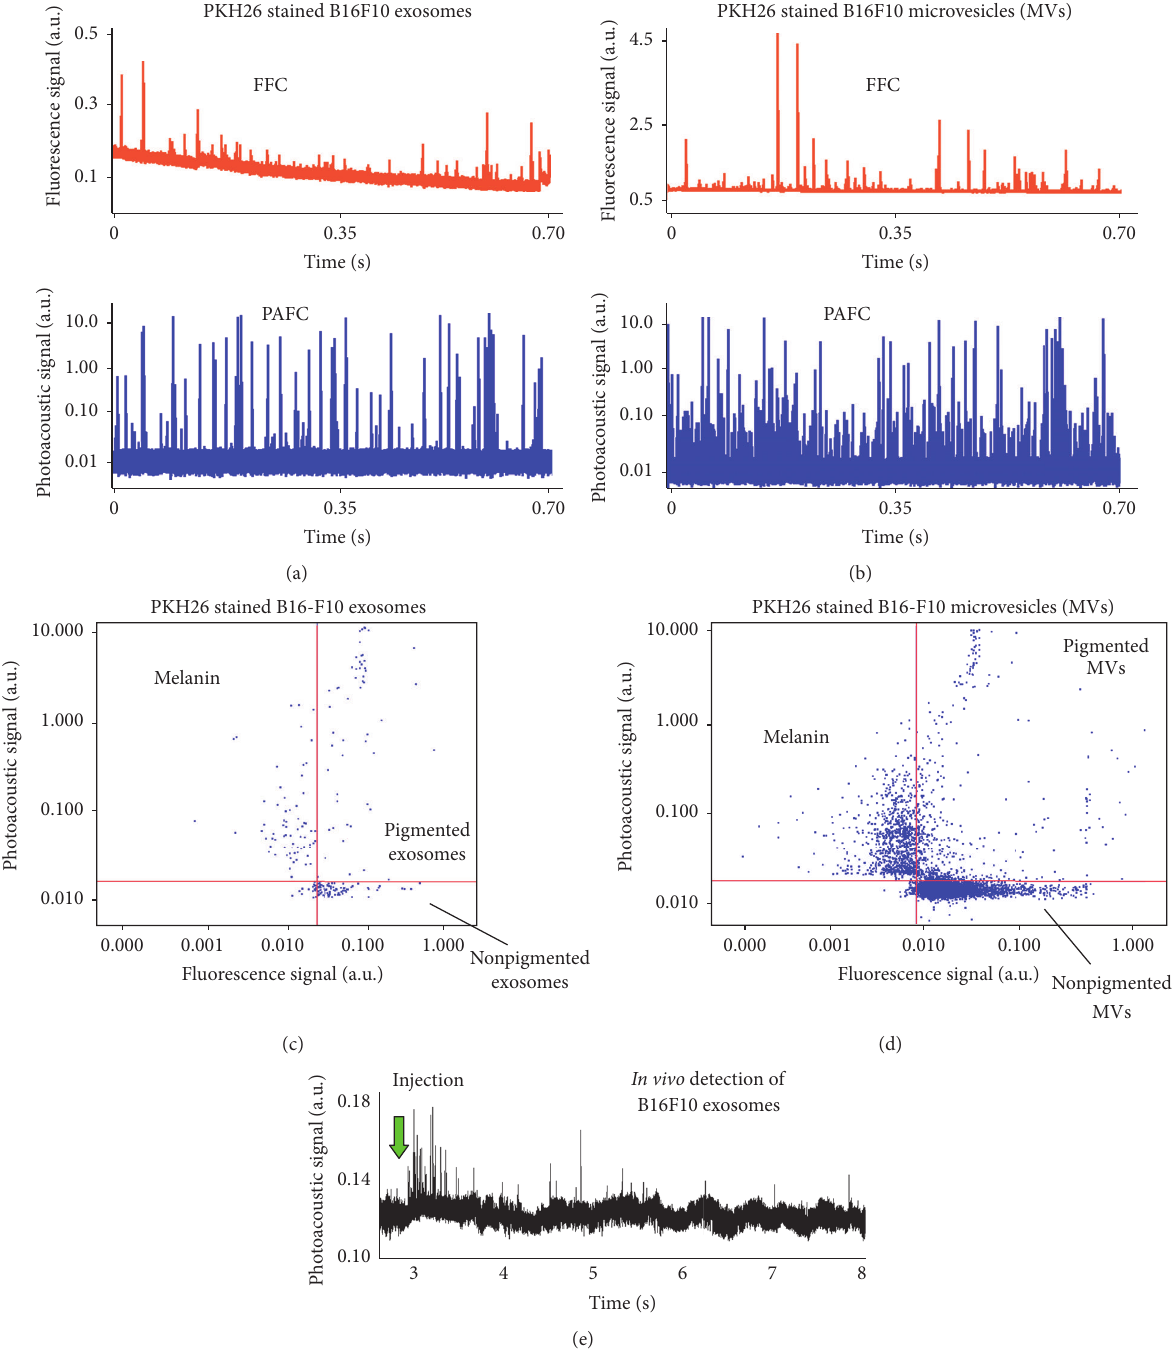
Figure 3: PA and fluorescence detection of CTPs in flow in vitro and in vivo . In vitro fluorescence PA signal traces of PKH26 dye stained exosomes (a) and microvesicles (b) from B16F10 melanoma cells in a 50 𝜇 m capillary tube. 2D analysis of exosome (c) and microvesicle (d) detection in (a) and (b). (e) In vivo PA detection of exosomes from B16F10 cells which were intravenously (i.v.) injected in a healthy control mouse. PAFC laser parameters: 10kHz pulse rate, 8ns pulse width, and 30–50 mJ/cm 2 energy